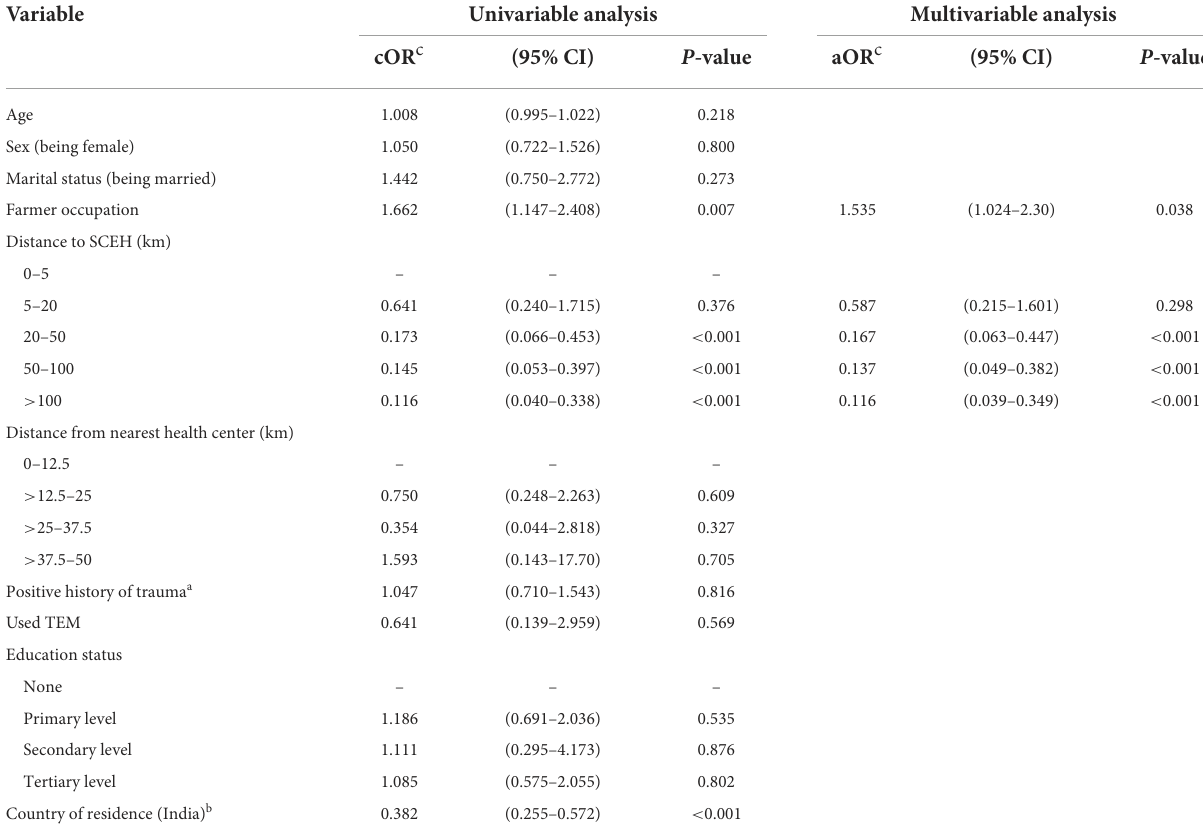
TABLE 3 Univariable and multivariable logistic regression analysis of factors associated with direct presentation to the eye hospital, n = 643.